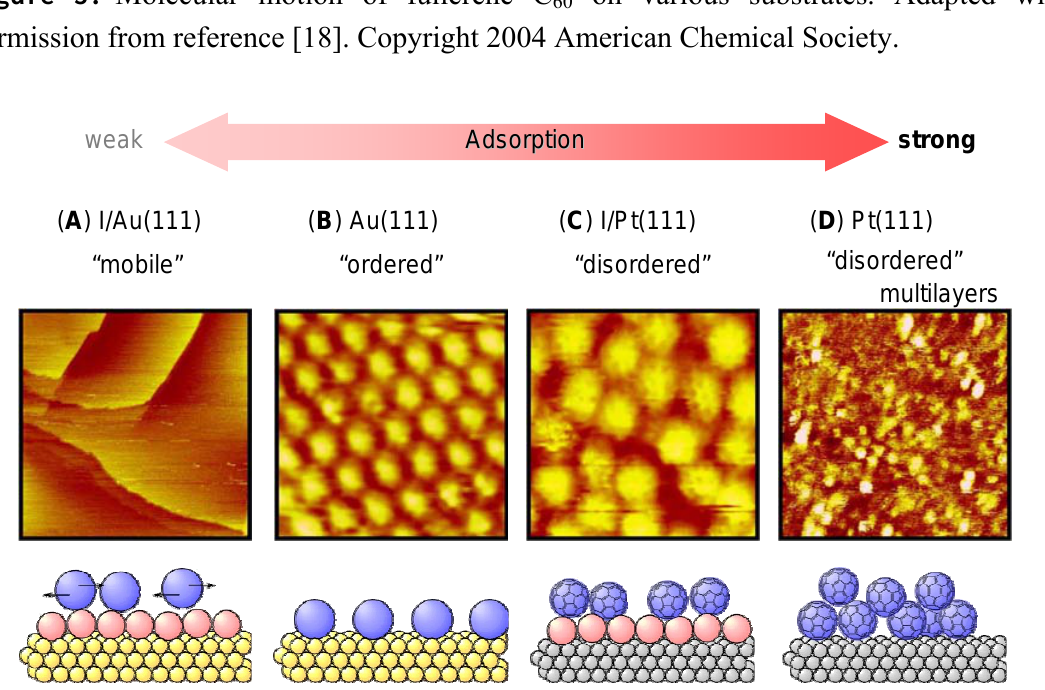
on various substrates. Adapted with 60